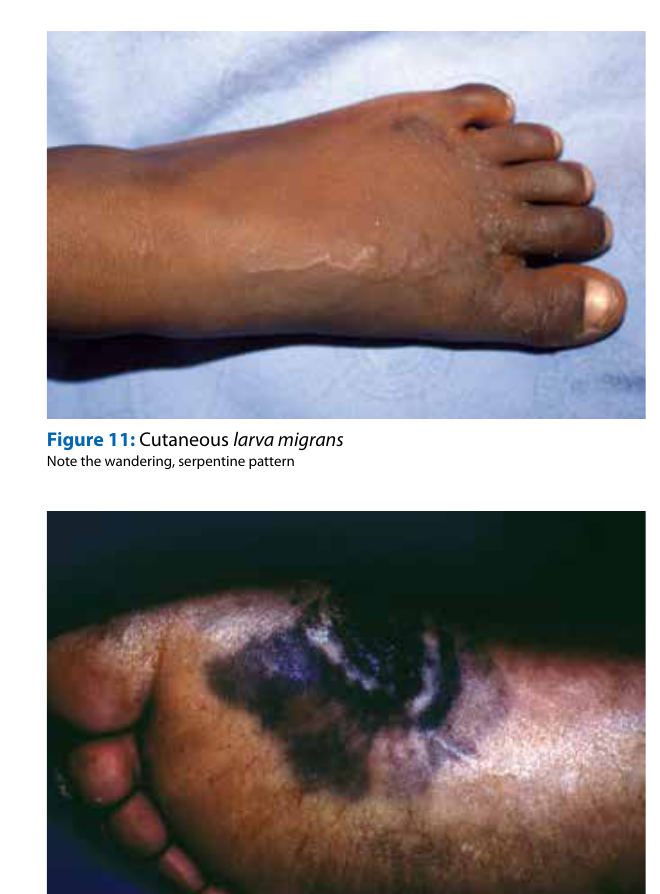
Figure 10: Pitted keratolysis